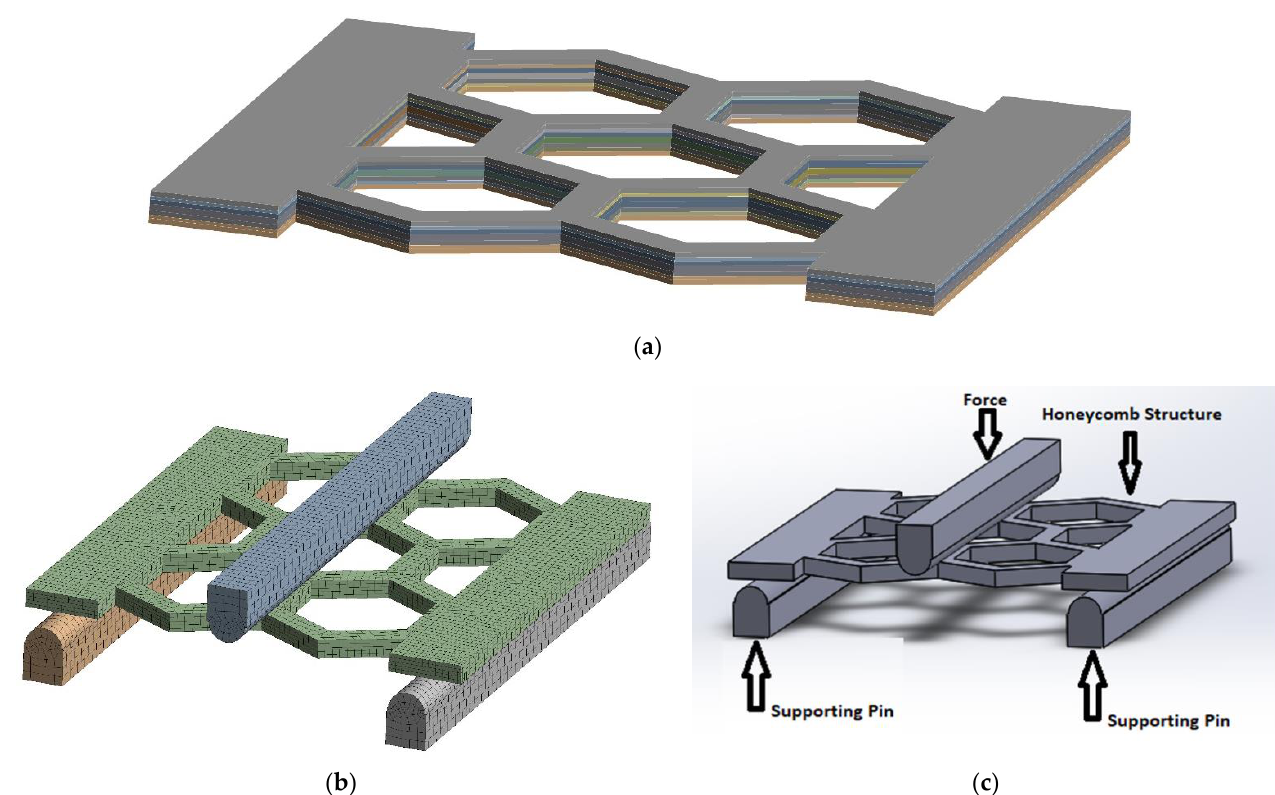
Figure 5. ( a ) Geometry of nylon honeycomb structure reinforced with fiberglass, ( b ) the corresponding mesh in ANSYS and ( c ) nylon honeycomb structure at three-point bending test.